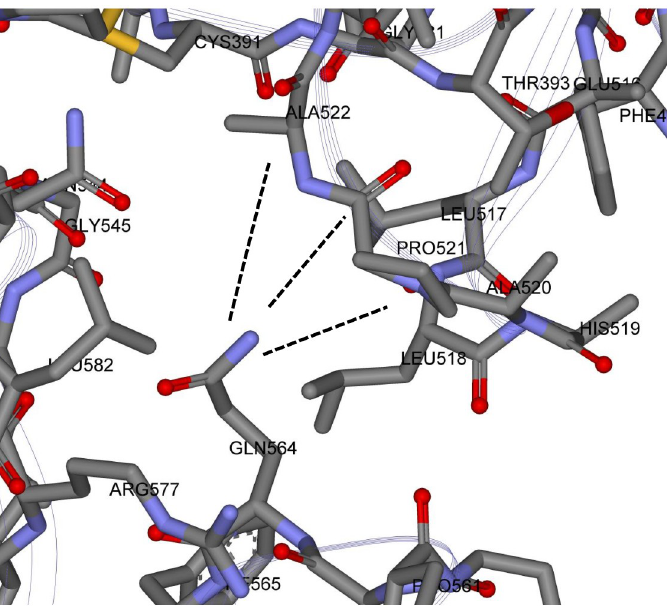
Fig 8. Zoomed View of possible molecular latch between the RBD and SD1 domain: Backbone atoms of ALA520 PRO 521 ALA 522 with the R-group of GLN 564. See S8 Table in S1 File for a complete listing of the dominant energetic interactions and their specific